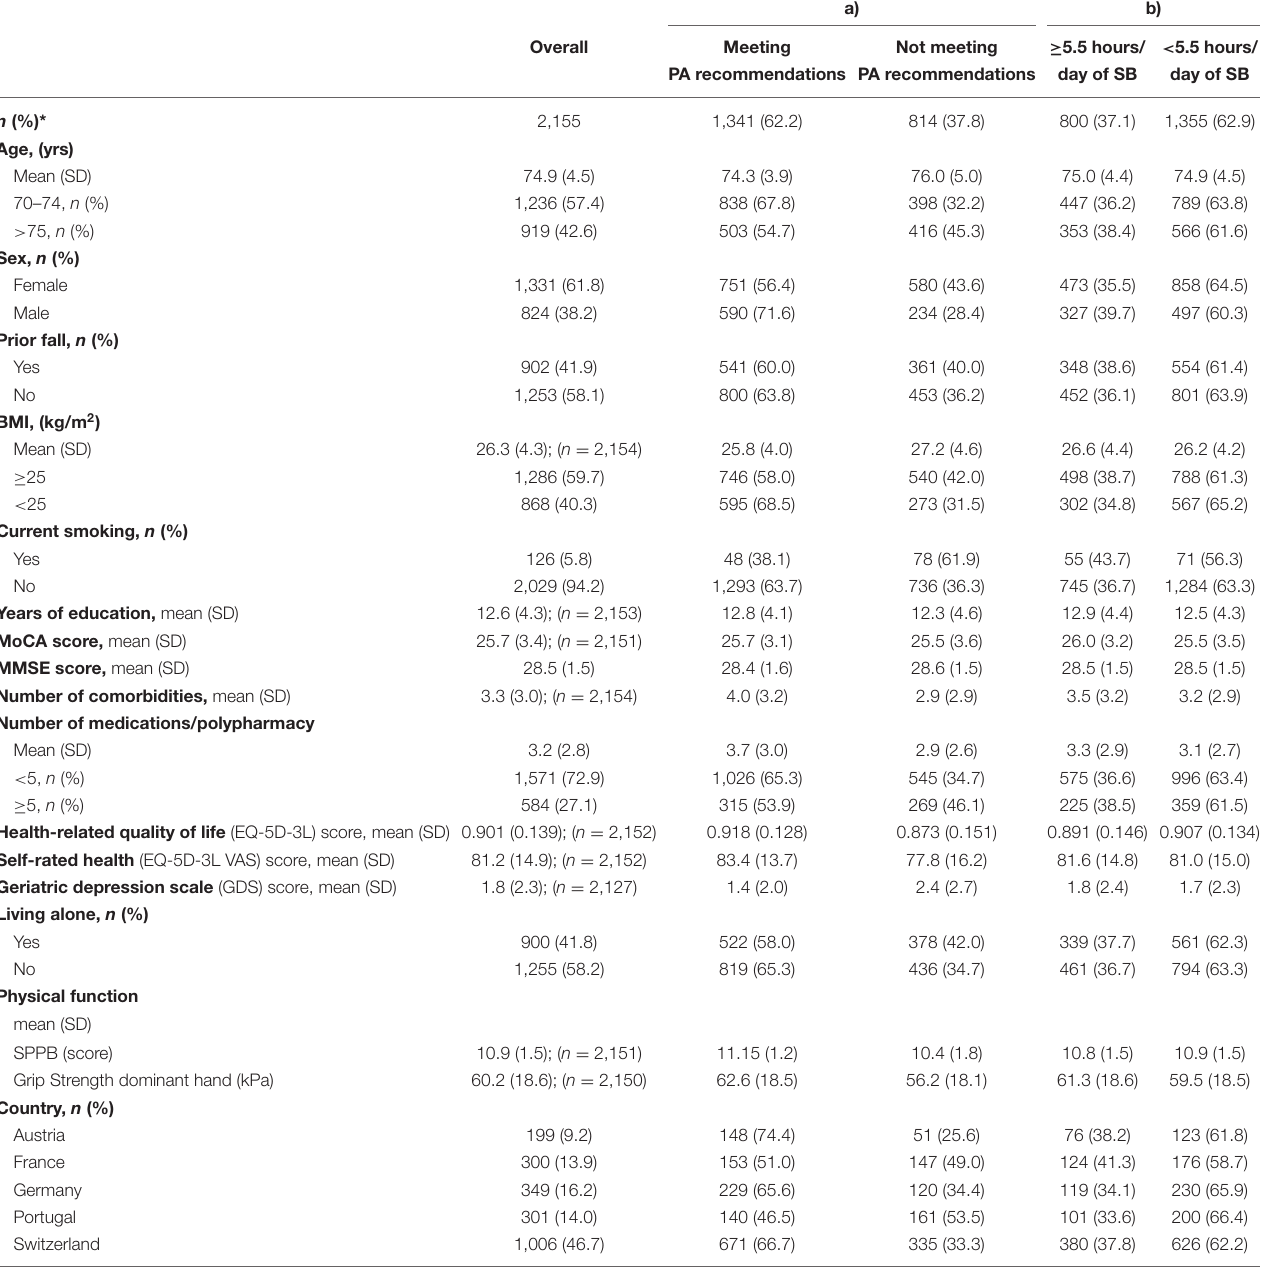
TABLE 1 | Baseline characteristics of the study population, a) by meeting or not meeting PA recommendations, b) by reporting ≥ 5.5 hours/day of SB or